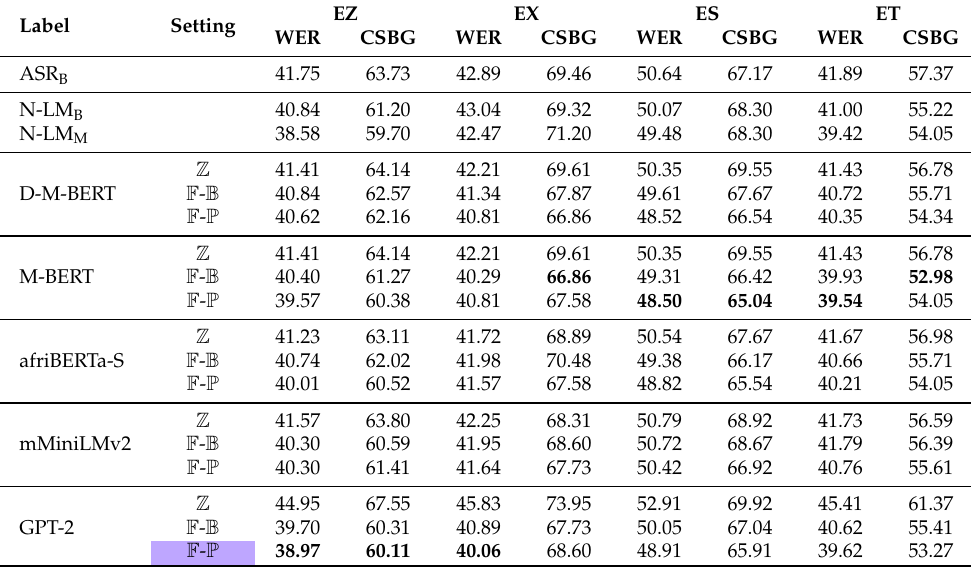
Table 8. Test set word error rates (WER) and code-switched bigram error rates (CSBG) when utilis- ing transformer models for N-best rescoring. Results are presented for each of the four respective language pairs: English–isiZulu (EZ), English–isiXhosa (EX), English–Sesotho (ES), and English– Setswana (ET). The model that afforded the best average speech recognition performance on the development set is highlighted. The best performance achieved on the test set amongst the multilin- gual models is presented in